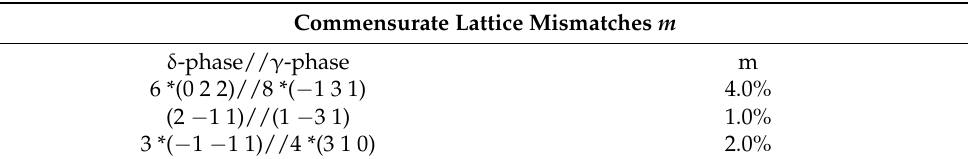
Table 4. Lattice mismatches among phases. * indicate that there are n cells in this particular crystallographic direction.